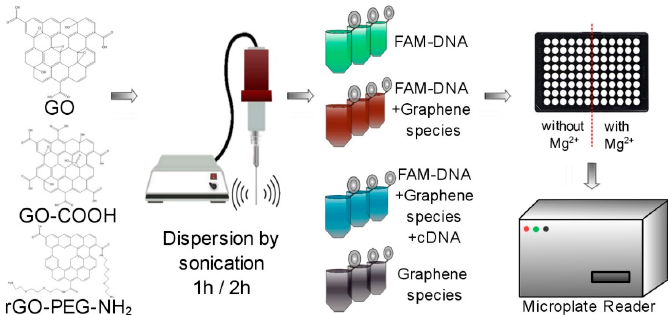
Figure 1. Schematic illustration depicting the experimental workflow.